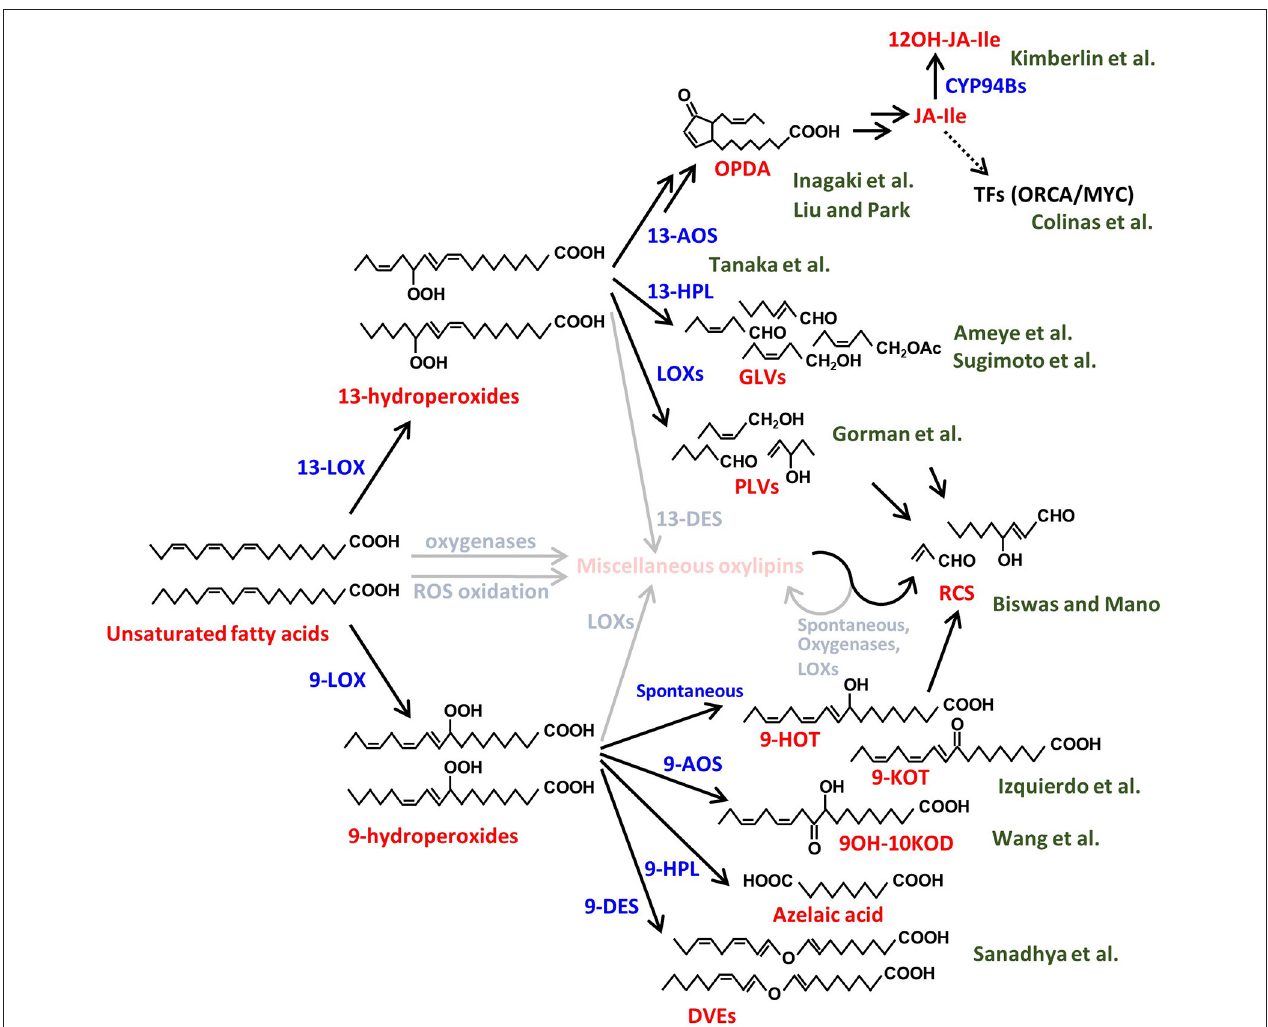
FIGURE 1 | Biosynthetic pathways of various plant oxylipins. Biosynthesis of the plant oxylipins is initiated by oxidation of the unsaturated fatty acids, e.g., linoleic acid and linolenic acid in this figure, enzymatically or nonenzymatically. The compound names are shown in red and the processes are shown in blue. The green characters behind the compounds show the author names in this Research Topic and the relationships between the authors’ papers and the compounds. The miscellaneous compounds and processes that are not described well in this Research Topic are shown in faded colors. LOX, lipoxygenase; AOS, allene-oxide synthase; HPL, hydroperoxide lyase; DES, divinyl ether synthase; CYP, cytochrome P450; ROS, reactive oxygen species; OPDA, 12-oxo-phytodienoic acid; JA-Ile, jasmonic acid-isoleucine conjugate; 12OH-JA-Ile, 12-hydroxy JA-Ile; TFs, transcription factors; GLVs, green leaf volatiles; PLVs, pentyl leaf volatiles; RCS, reactive